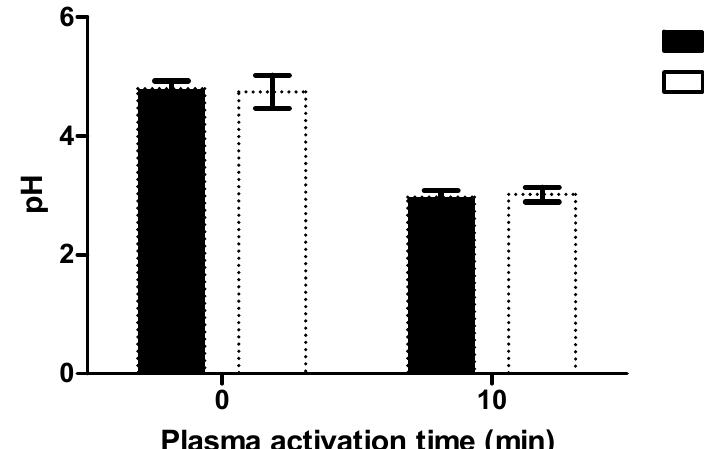
Figure 6. pH measurements of PAW and PAS the first day of their generation.